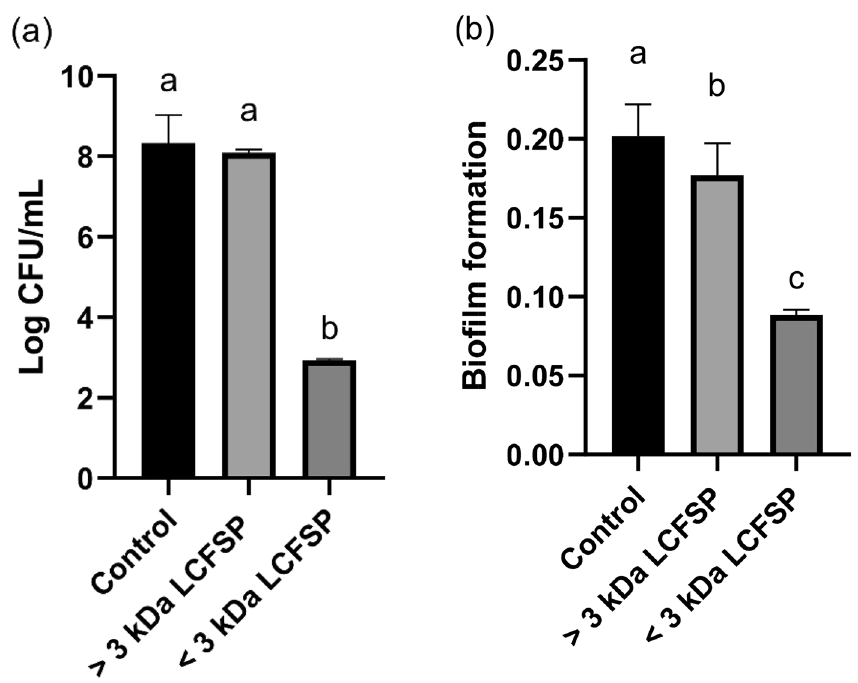
Figure 4. Colony forming unit (CFU) ( a ) and biofilm formation ( b ) of Gardnerella vaginalis treated with precipitated protein fraction of the Lactobacillus paracasei CH88 cell-free supernatant (LCFSP; 1 mg/mL). Bars are means and standard errors of the means (n = 3) of triplicate experiments. Different small letters indicate significant differences ( p < 0.05; one-way ANOVA and Duncan’s multiple range test). ( p < 0.05; one-way ANOVA and Duncan’s multiple range